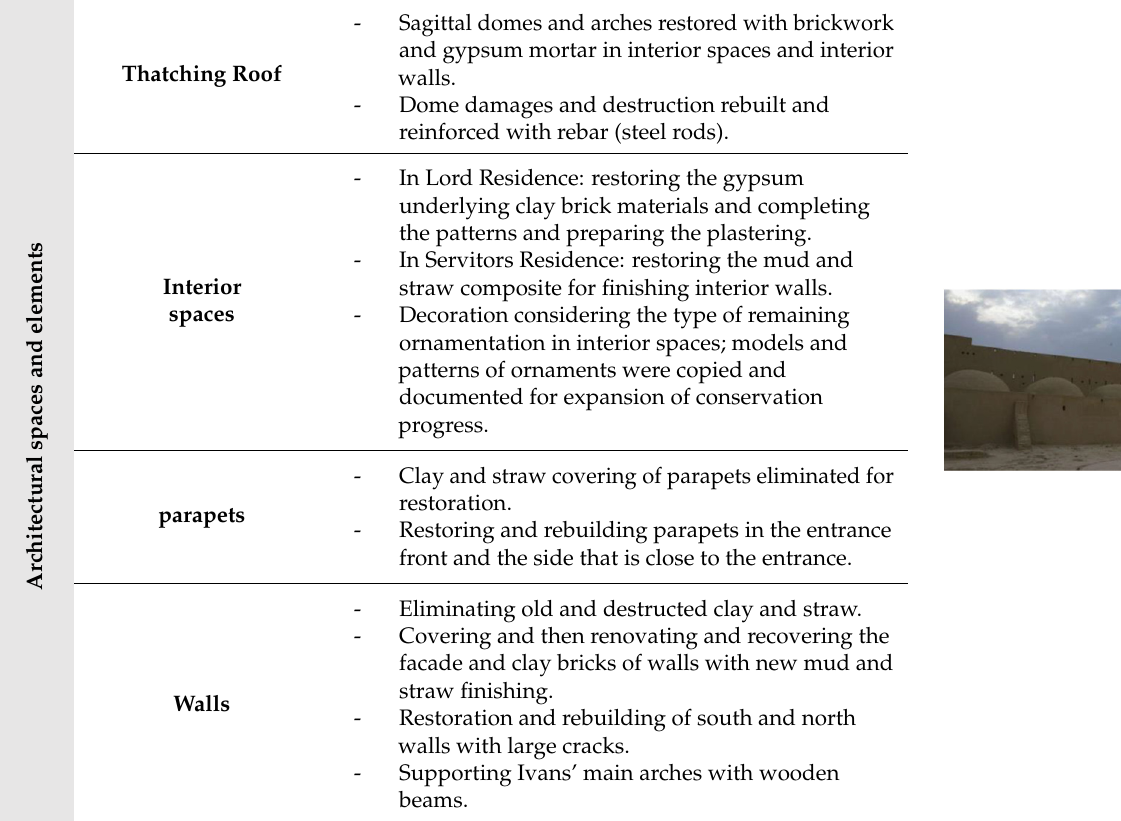
Table 5. Conservation plan for physical spaces (Mochi Castle).